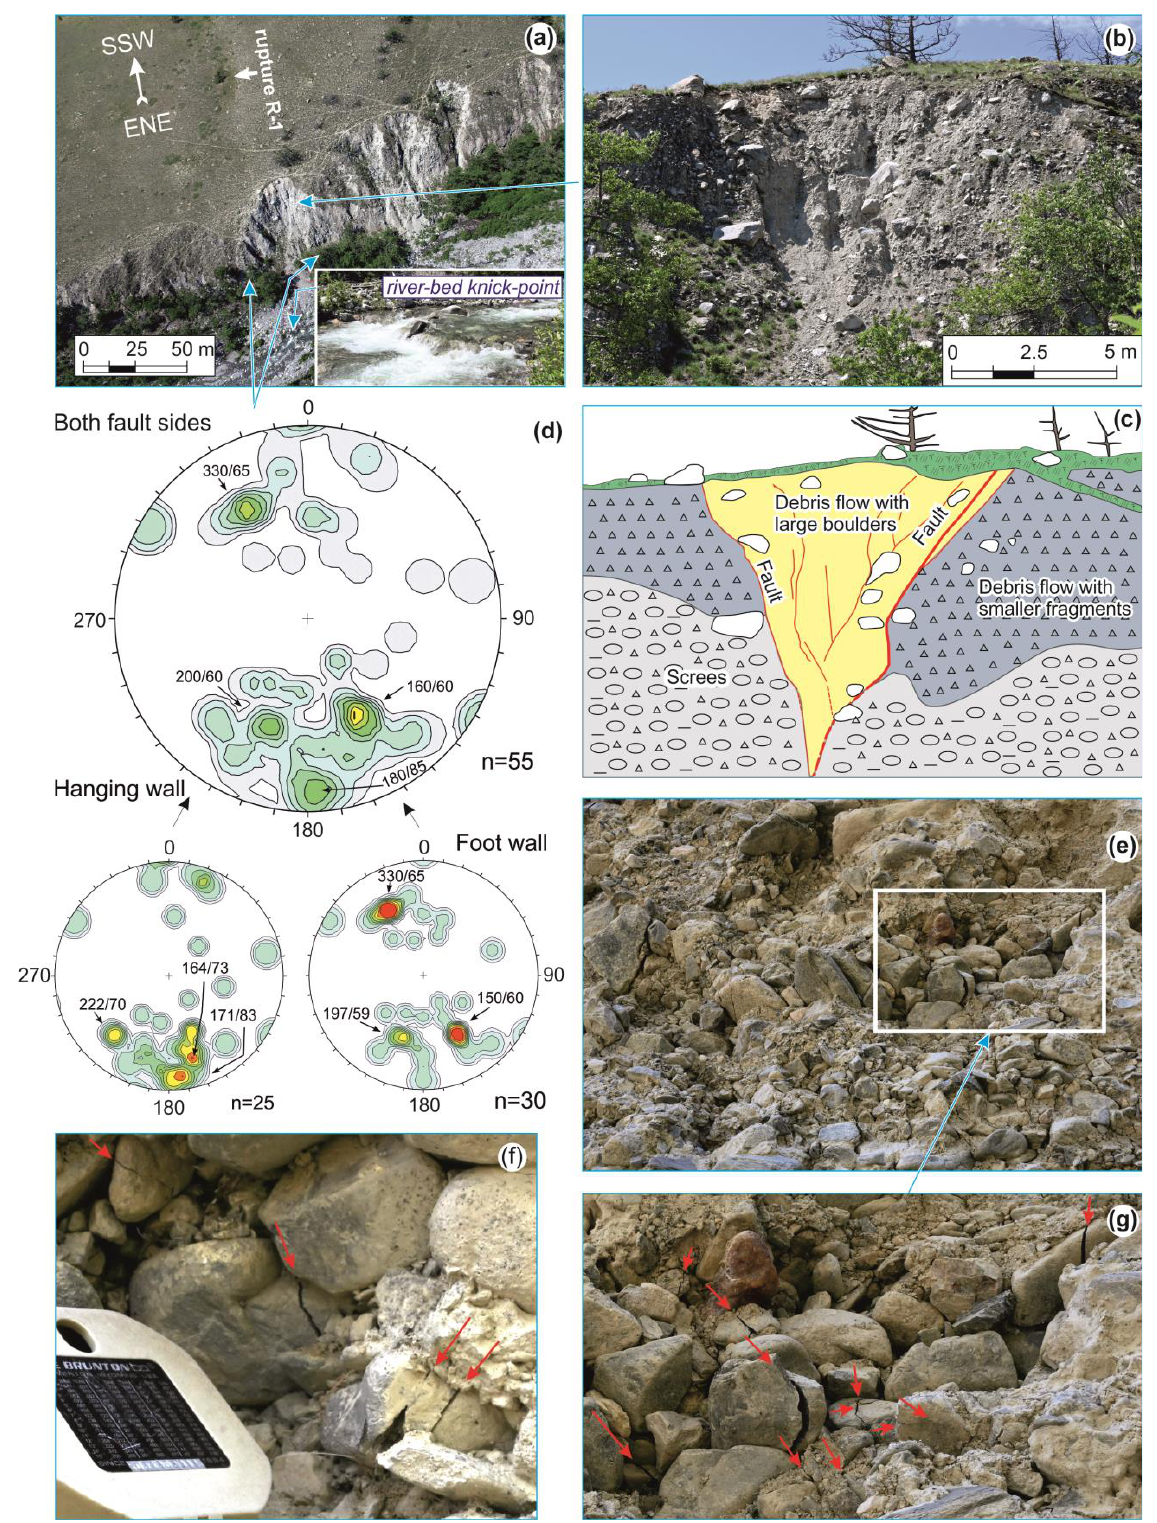
Figure 7. Site 4: ( a ) Shear zone R-1; ( b , c ) light brown cemented debris flow deposits filled the rupture (see location in Figure 4); ( d ) diagrams of fractures in the alluvium underlying debris flow deposits (Wulff net upper hemisphere projection; n—number of measurements; counting circle size 1%; intensity isolines are 1, 2, 3 and >; different colors show density concentration from 0 (white) to > 9 (red)); ( e – g ) fractures in alluvium shown by red arrows.